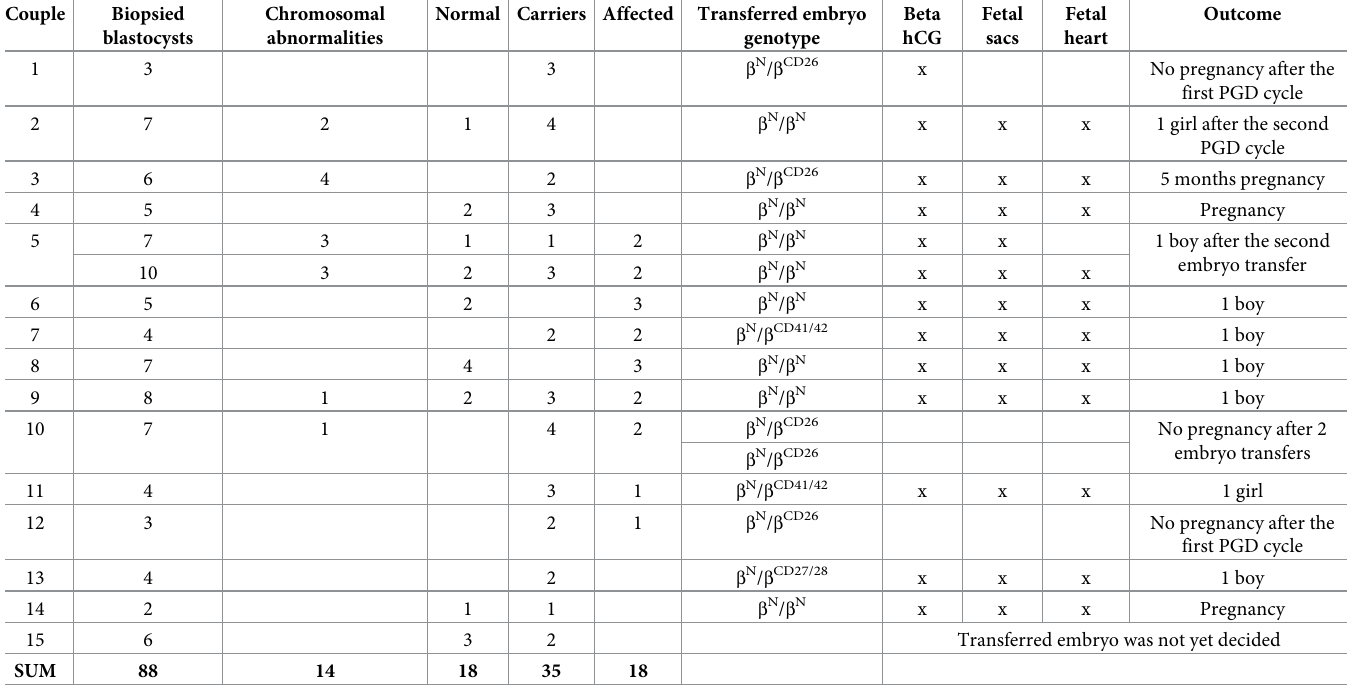
the β -thalassemia population due to cross-ethnic marriage. Thus, despite the attempt of expanding blood transfusion network between national to provincial hospitals to treat β -thal- assemia patients, it is being exhausted due to the increasing rate of β -thalassemia infants [13]. This problem raises both financial and social burden to the patients’ family as well as the Table 4. Summary of PGD